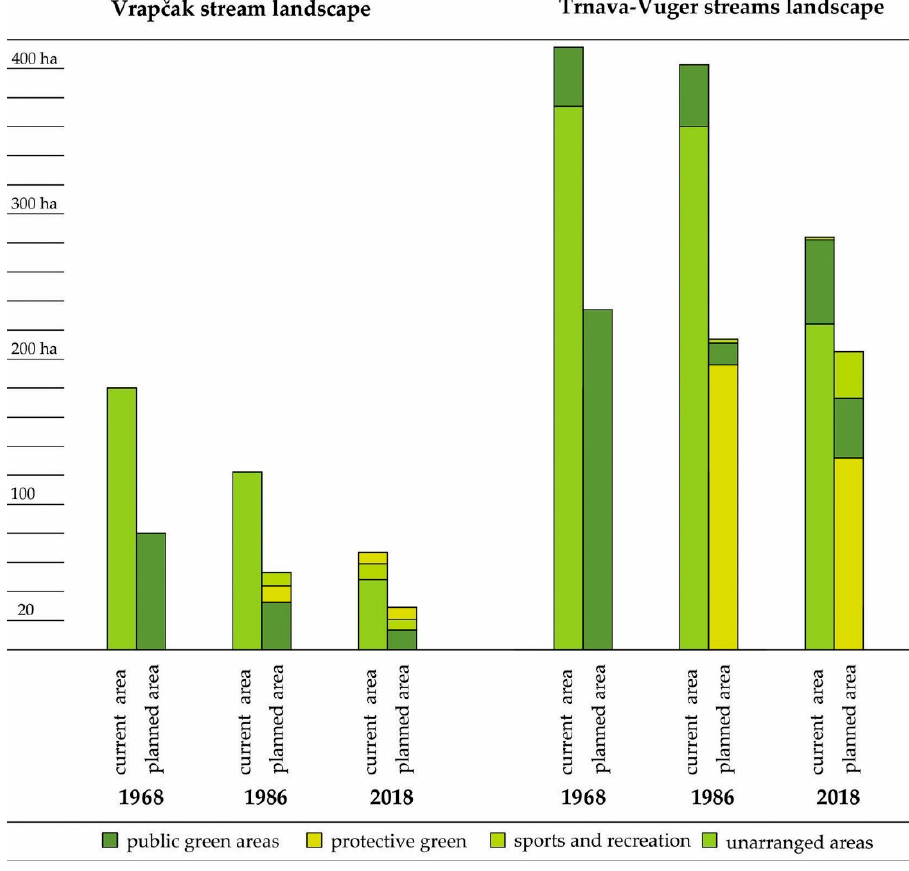
Figure 8. Stream landscape change comparison. Source: Authors.